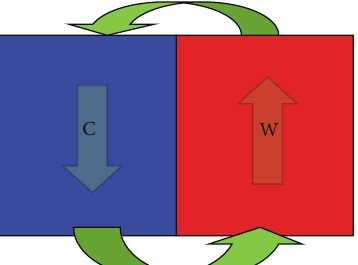
Figure 3: Schematic depiction of the atmosphere with a horizontal temperature gradient. The red column (W) has a higher temperature than the blue column (C). The arrows represent air motions. The arrow in the red column represents rising air and that in the blue column represents sinking air, while the arrows across the two columns represent convergence or divergence of air between